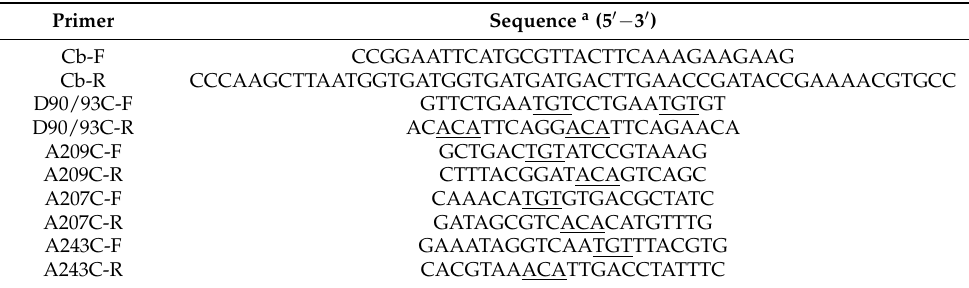
Table 3. Oligonucleotides used for the construction of